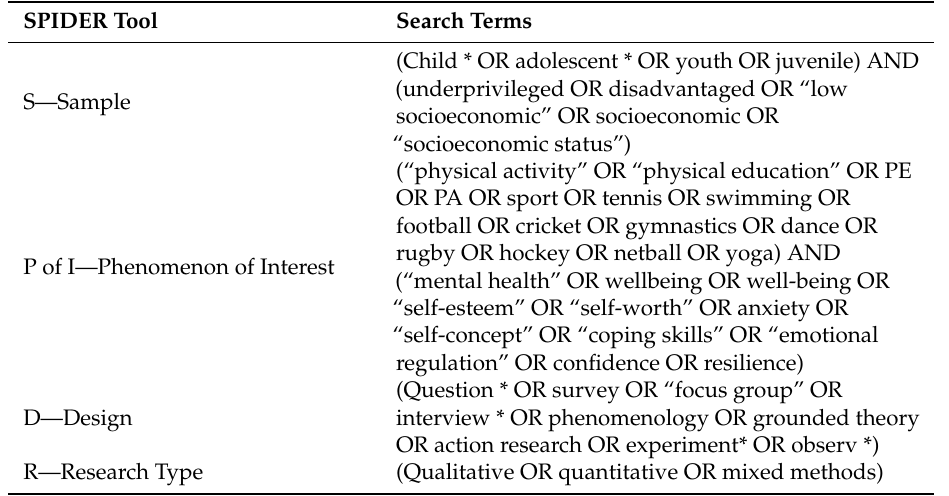
Table 1. Search Terms Using SPIDER